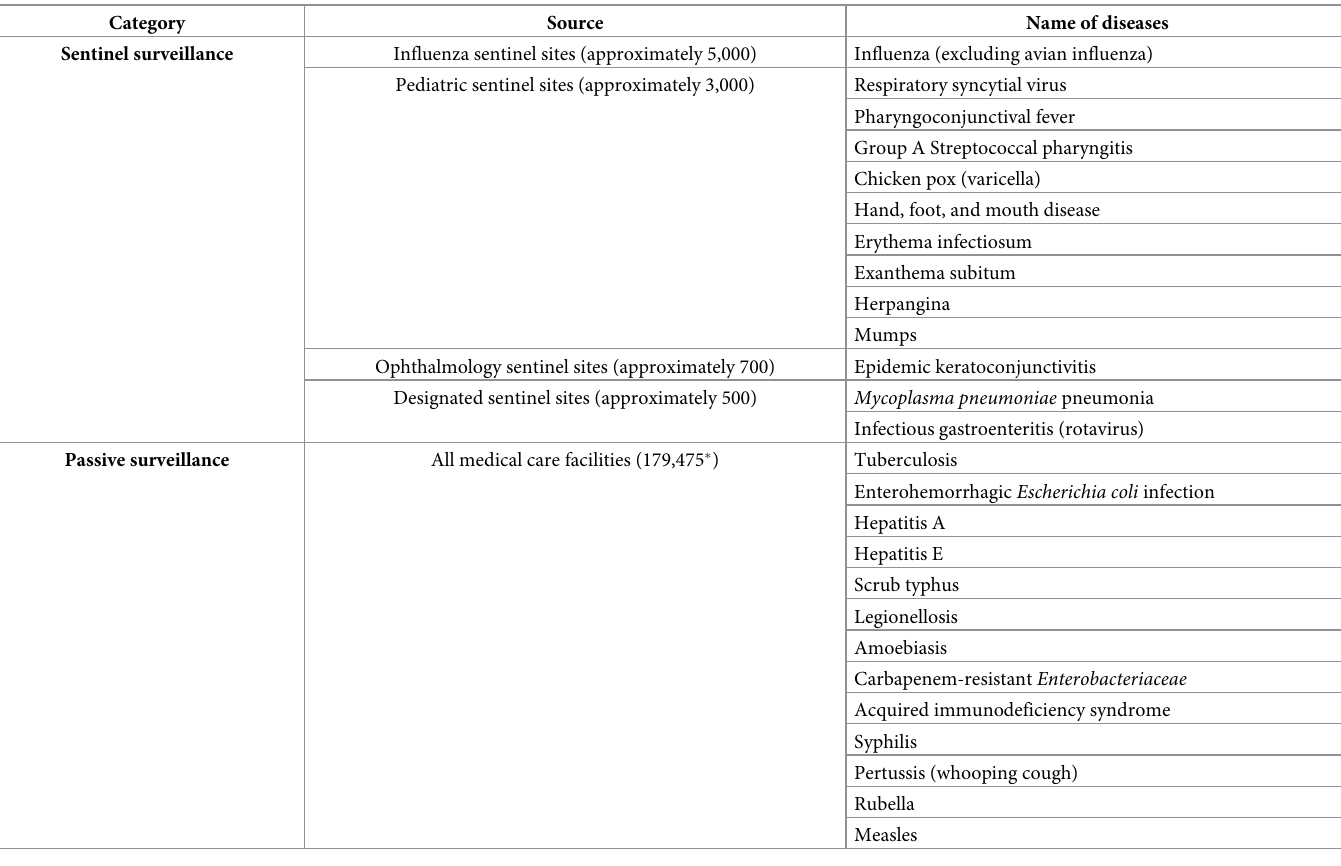
Table 1. Classification of common infectious diseases by the Japanese surveillance